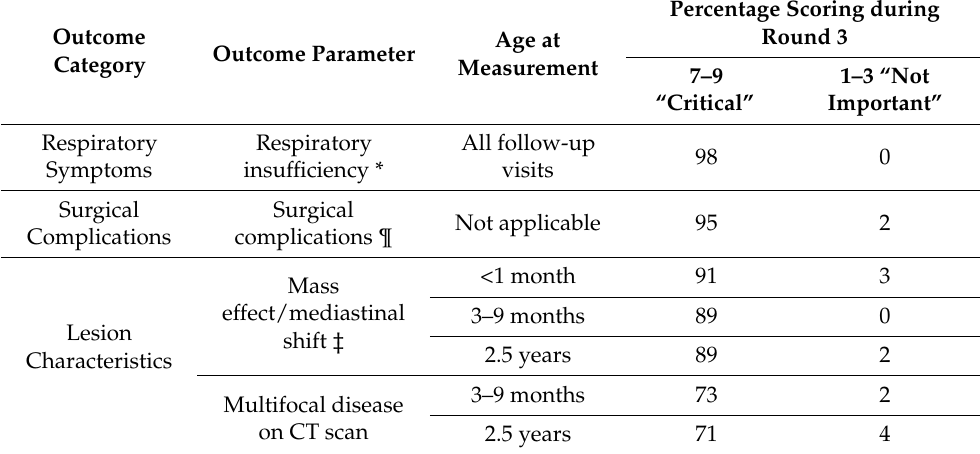
Table 2. Final core outcome